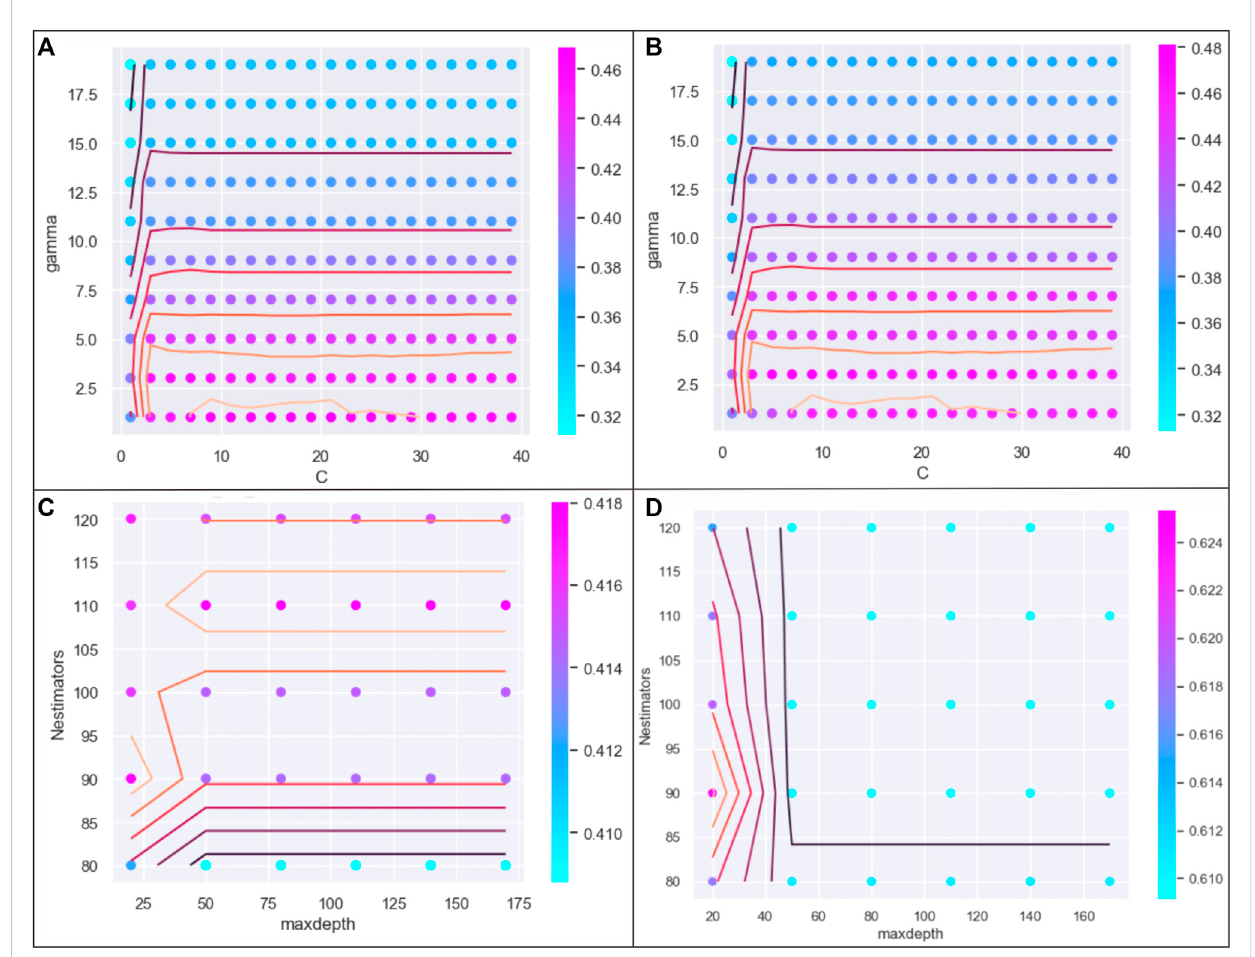
FIGURE 10 Cross-validation and parameter optimization analysis of models (a) and (f): (A) and (C) show the scores of forecast accuracies caulated by using training samples in model (a) and (f); (B) and (D) show the scores of forecast accuracies caulated by using testing samples in model (a) and (f).